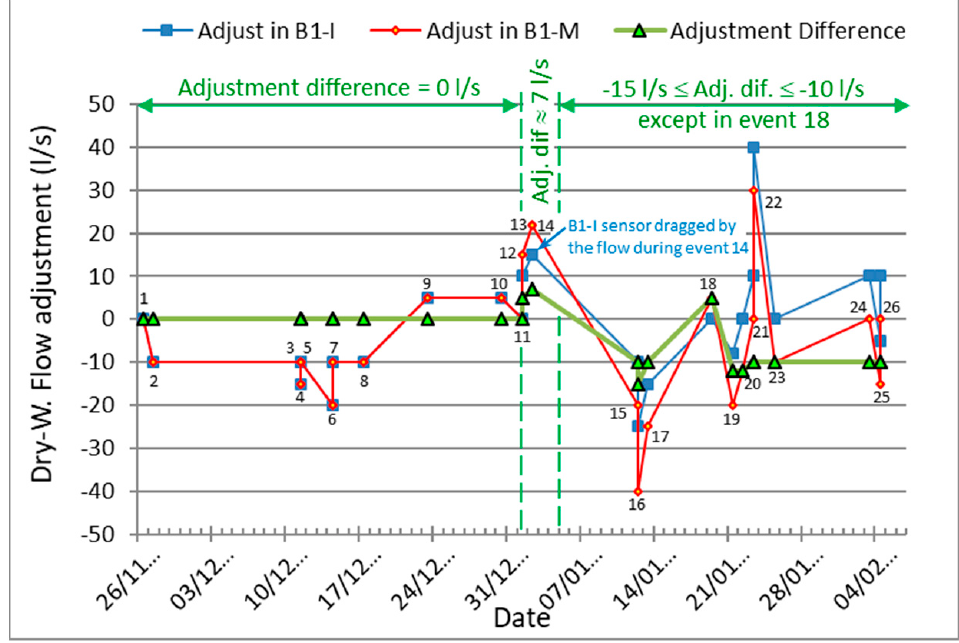
Figure 9. Values of the dry weather flow adjustment per modelled event.